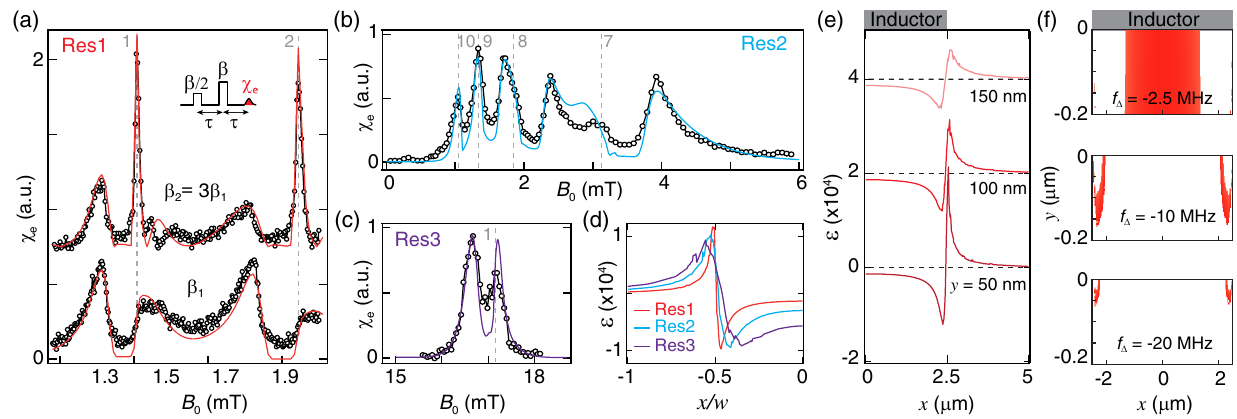
FIG. 2. Strain spectroscopy. (a) – (c) Measured (symbols) and numerically modeled (solid lines) echo-detected spin spectroscopy for three resonators. The Hahn-echo sequence consists of square pulses of amplitudes β = 2 ; β , which are each 2 μ s long and averaged at a repetition rate of 10 s (Res1), 2 s (Res2), and 0.5 s (Res3). The area under the echo is labeled as χ . Vertical dashed lines mark the e position of spin transitions in the absence of any strain. The transition numbers ( i ¼ 1 ; 2 ; … ; 10 ) are marked as described in Fig. 1(d). In panel (a), the top (bottom) measurement is done at a pulse amplitude β 2 ¼ 15 × 10 6 s − 1 = 2 ( β 1 ¼ 5 × 10 6 s − 1 = 2 ). (d) Comparison of the ϵ ϵ = 3 at a fixed depth y ¼ 75 nm across resonators and (e) at different depths in Res1. hydrostatic component of strain ε ¼ ð ϵ xx þ yy þ zz Þ Curves have been offset by 2 × 10 − 4 for clarity. (f) Inferred location of spins (from COMSOL simulation) for different f Δ within a square bandwidth of (cid:3) 0 . 2 f Δ in